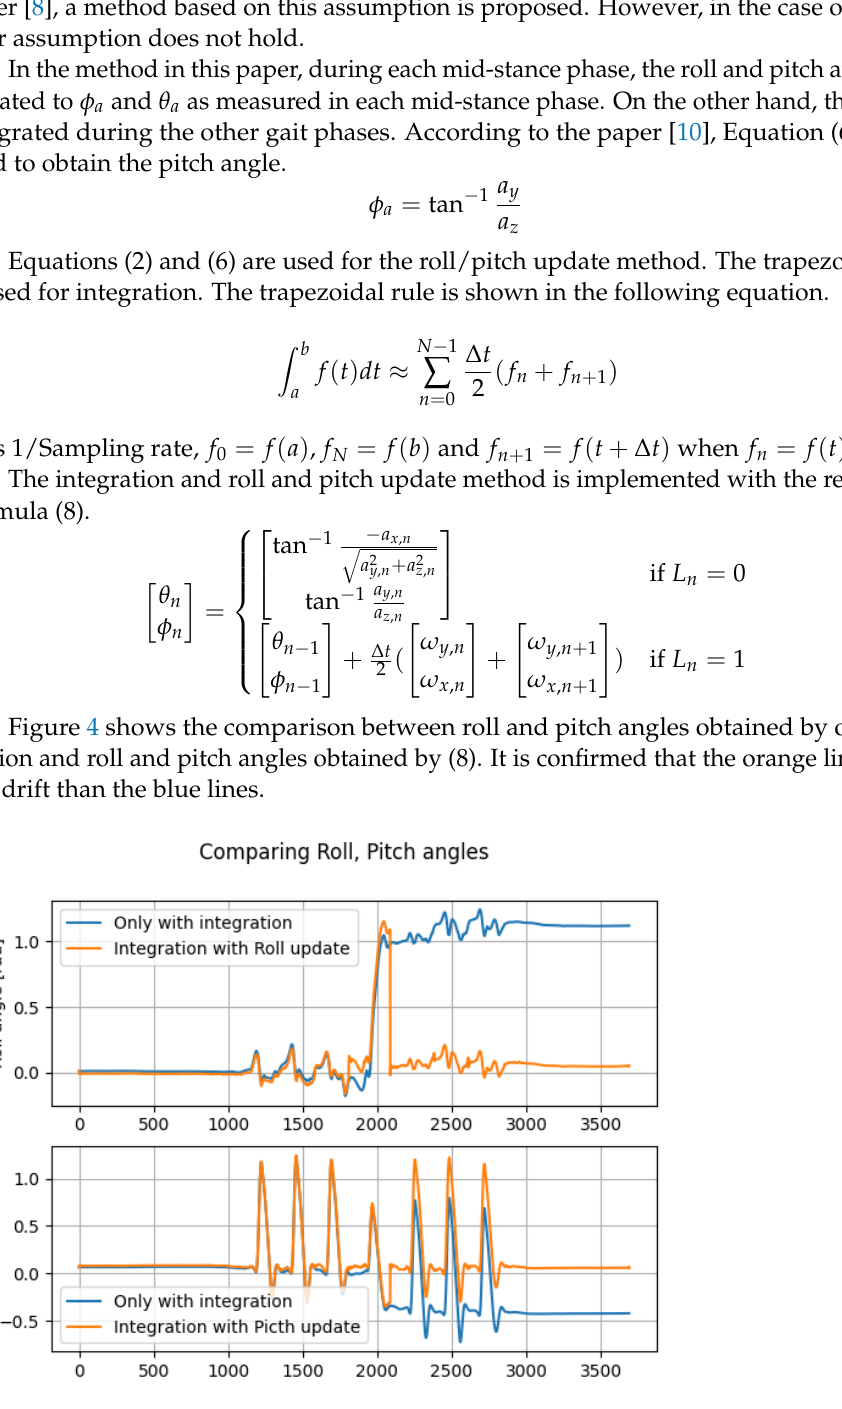
Figure 4. Comparison between attitude angles by only integration and attitude angles by integration with the roll/pitch update (the horizontal axes and vertical axes denote the index and roll or pitch angle [rad],